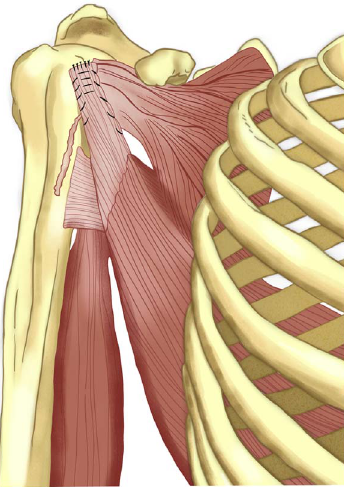
Figure 6. Latissimus dorsi tendon transfer for irreparable subscapu- laris tendon tear.